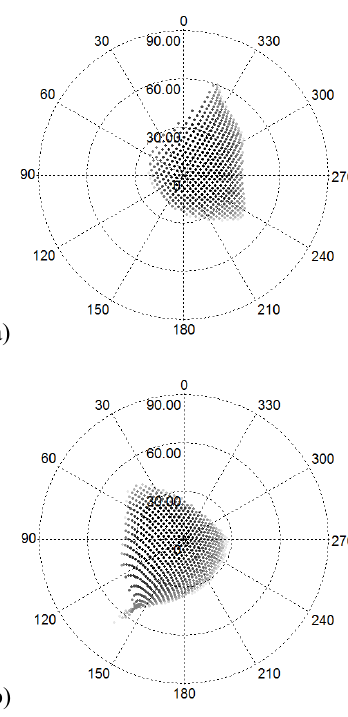
Figure 4. Backscattering semi-sphere, the point in the center of semi-sphere corresponds to the backscattering point: a) – the distribution of the non-specular beam in backscattering direction (highlighted by blue in Fig. 3); b) – the distribution of the reciprocal non-specular beam